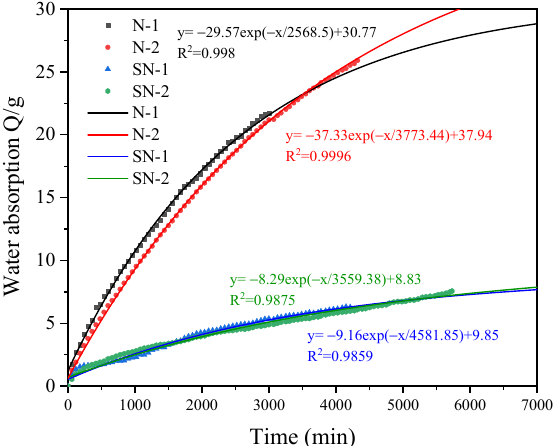
Figure 9. Fitting curves of water absorption with time change.